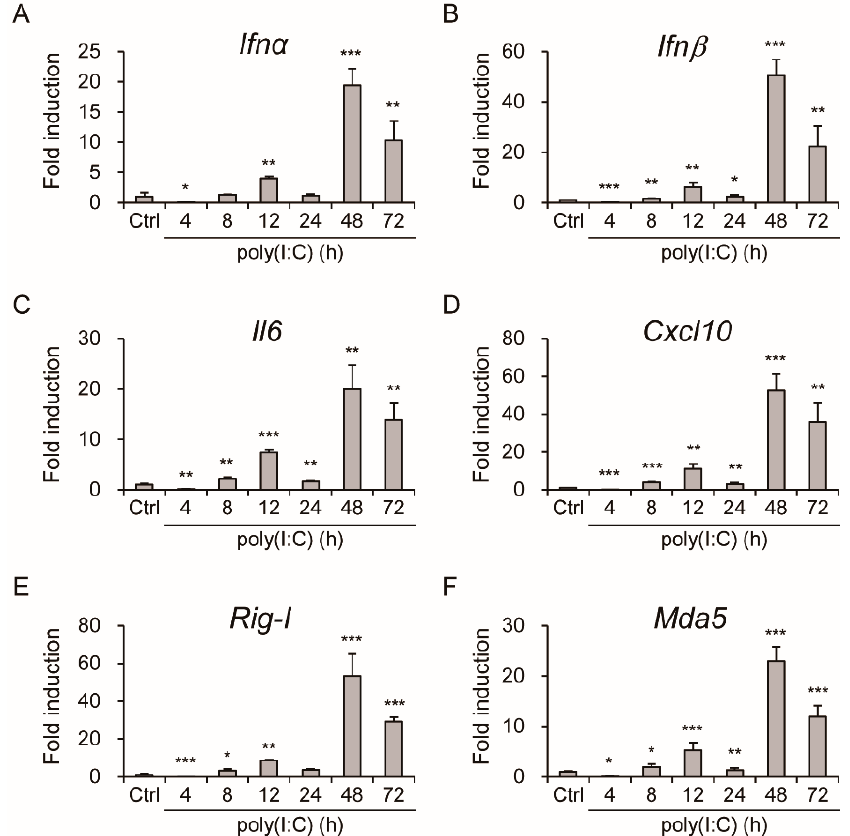
Figure 2. Expression of innate immune and inflammatory genes in poly(I:C)-stimulated IECs. ( A – F ) qPCR of mRNA expression of Ifn α , Ifn β , Il6, Cxcl10, Rig-I and, Mda5 at indicated times in IECs (1 × 10 6 ) stimulated with poly(I:C) (15 µ g / mL). Gene relative expression normalized to that of Gapdh . Data of fold induction compared with control showed as means ± SD ( n = 3). Student’s t -test *, p < 0.05; **, p < 0.01; ***, p < 0.001; compared with control.